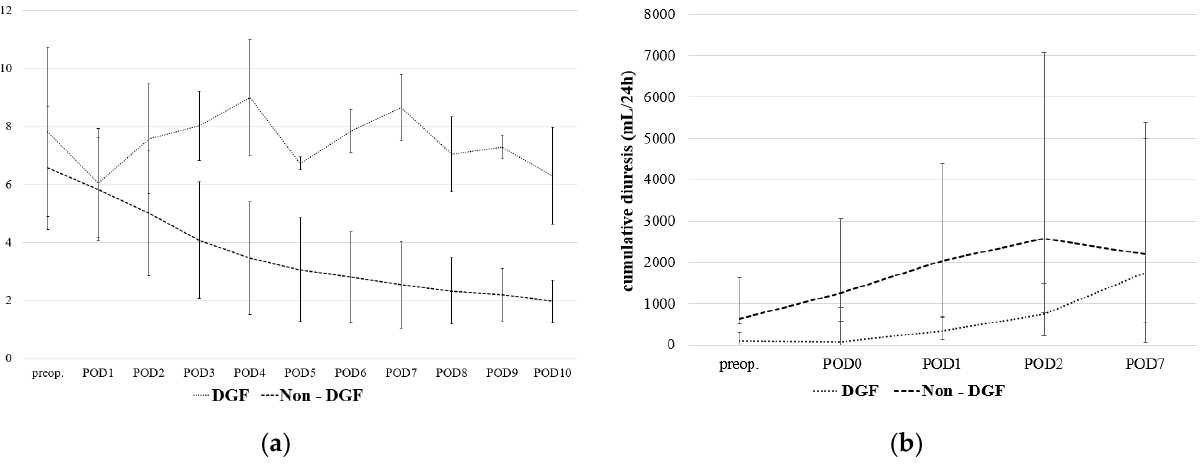
Figure 2. Comparison of average serum creatinine ( a ) and cumulative diuresis ( b ) between patients with normal postoperative graft function (non-DGF) and delayed graft function (DGF) over time (POD, postoperative day) following kidney transplantation. Data are expressed as a mean and standard deviation ( a ) or the median and Q1–Q3 interquartile range ( b ), respectively.